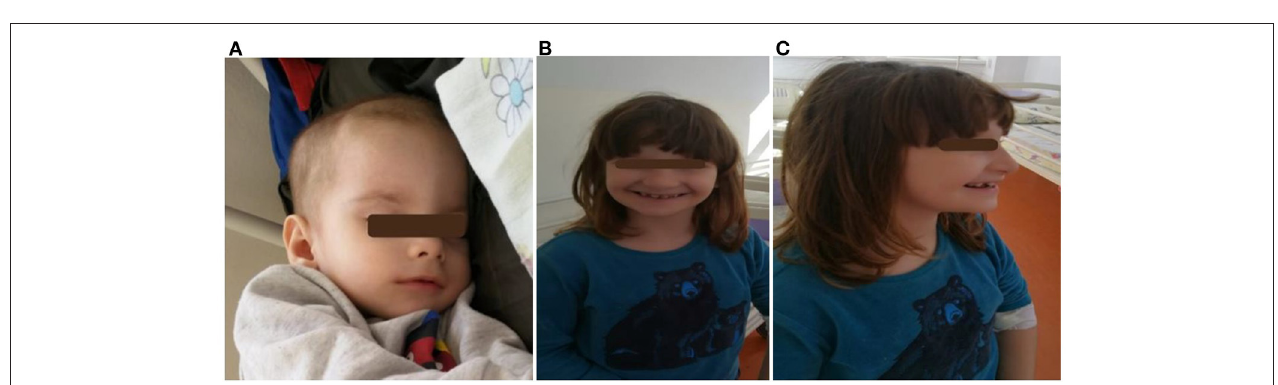
FIGURE 2 | Two siblings: (A) a 3 month-old infant (child 5) with craniofacial dysmorphism; (B,C) a 5- year 5-month-old girl (child 3) with craniofacial dysmorphism, mandibular hypoplasia, dental abnormalities, malocclusion, and intellectual